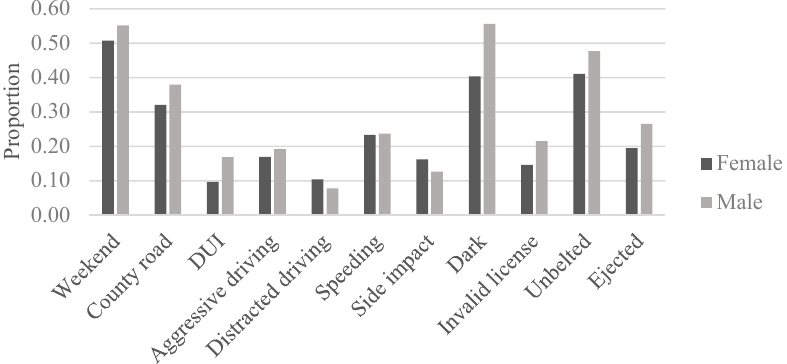
Figure 2. Crash factor proportions by gender.